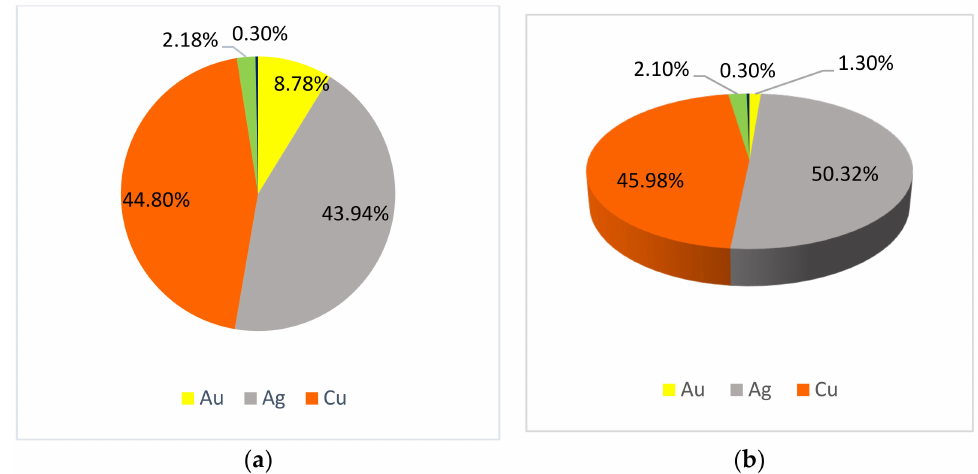
Figure 5. Metal content in liturgical vestments: ( a ) on the surface ( b ) in cross-section.